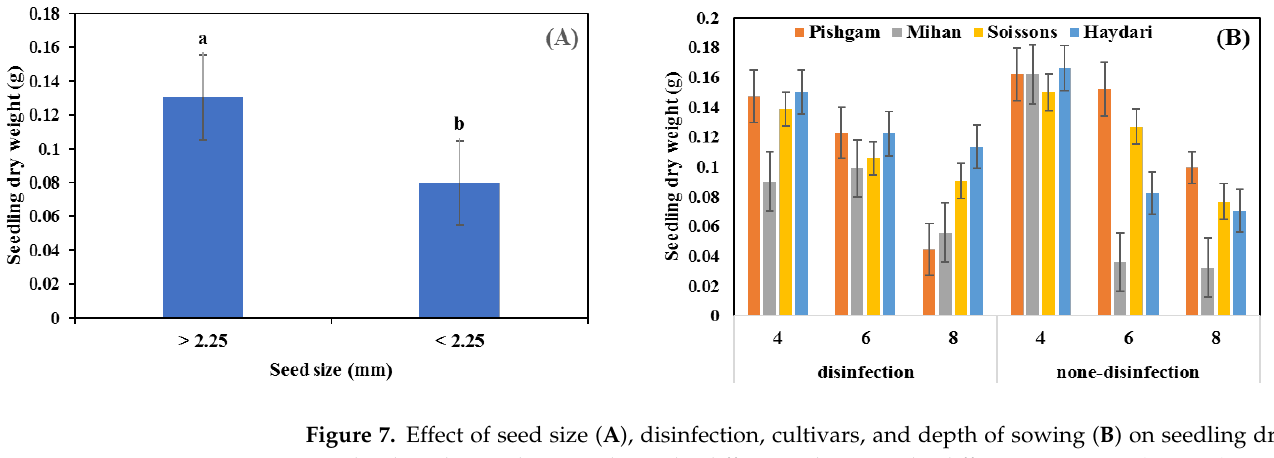
Figure 7. Effect of seed size ( A ), disinfection, cultivars, and depth of sowing ( B ) on seedling dry weight.The columns’ letters indicate the differences between the different treatments ( p < 0.05) using the LSD test.